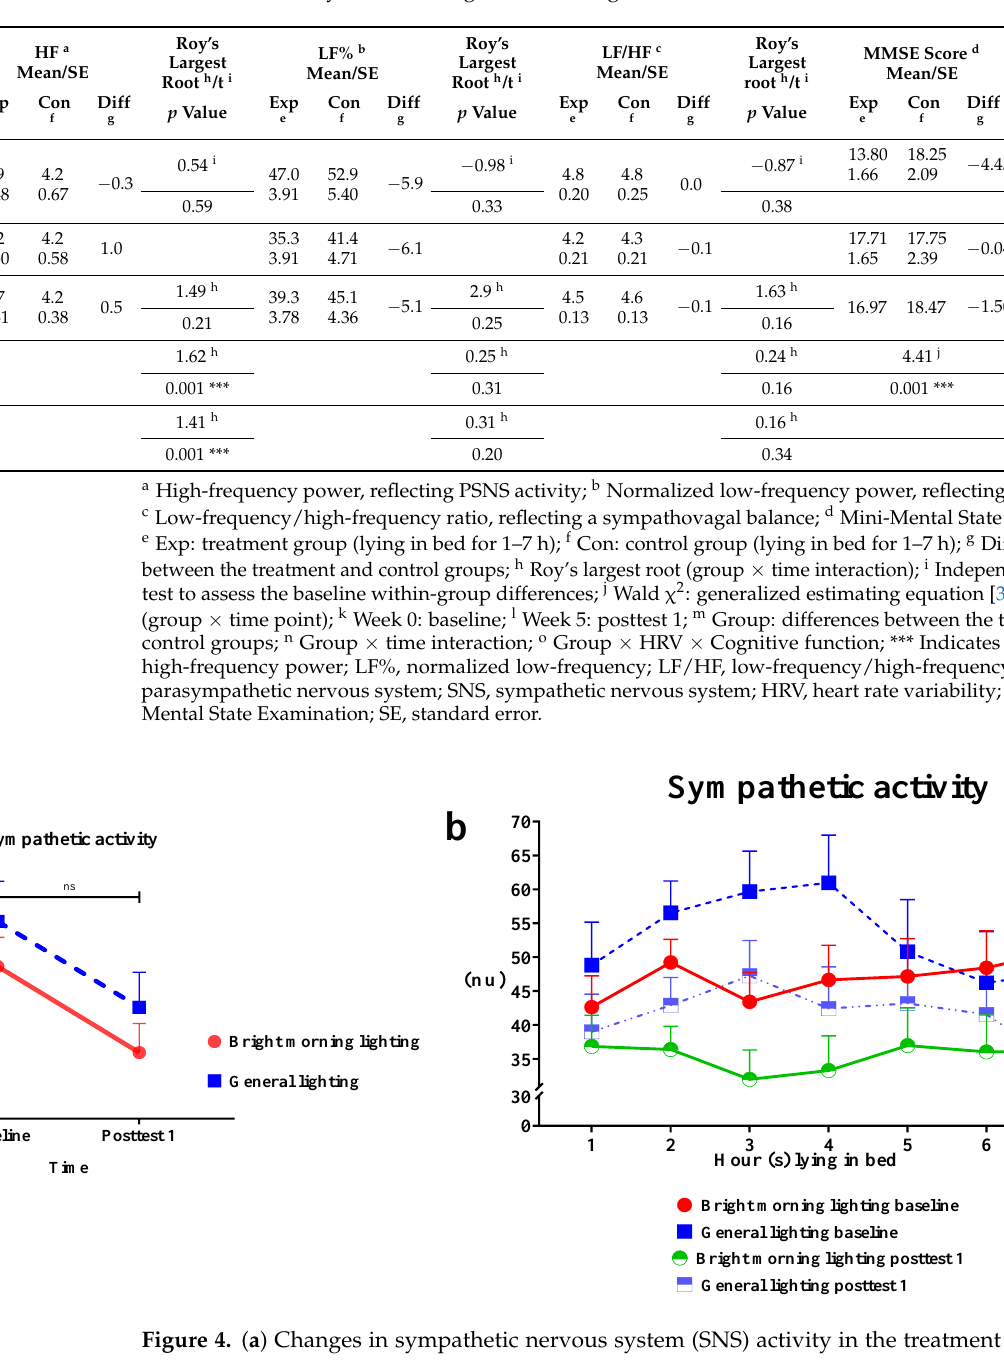
Table 2. GLM analysis of the longitudinal changes in HRV and MMSE scores.